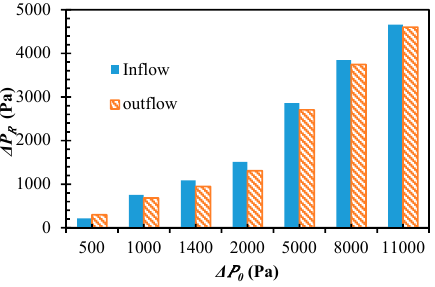
Figure 19. Comparison of the total pressure change across the rotor of the outflow and inflow turbine configurations.